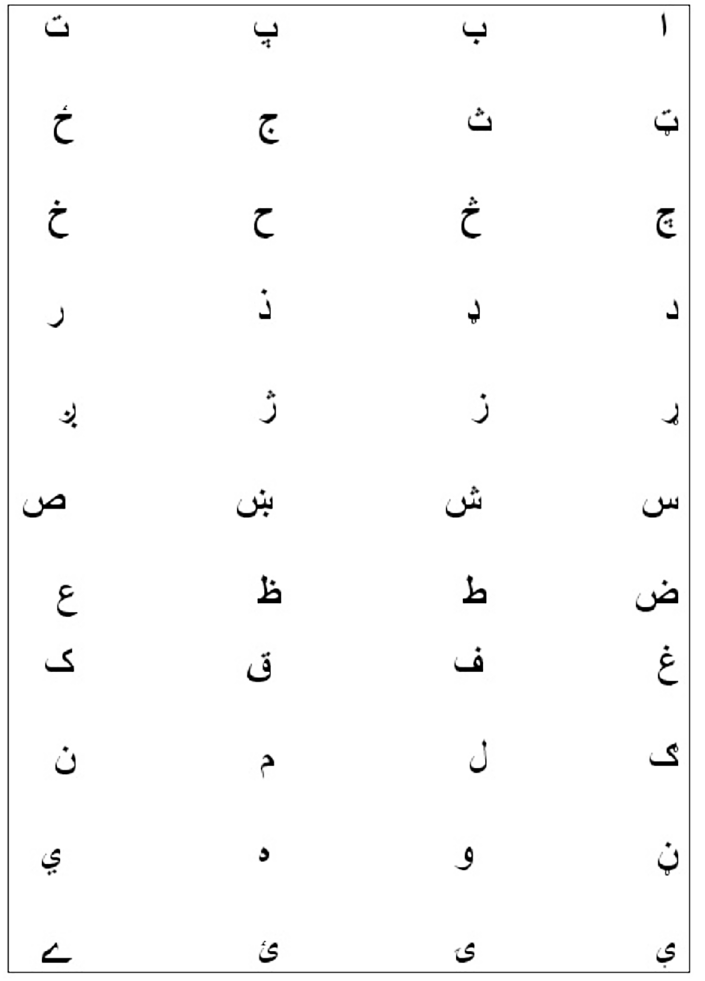
Fig 1. Pashto Characters. Pashto has 44 basic Alphabets